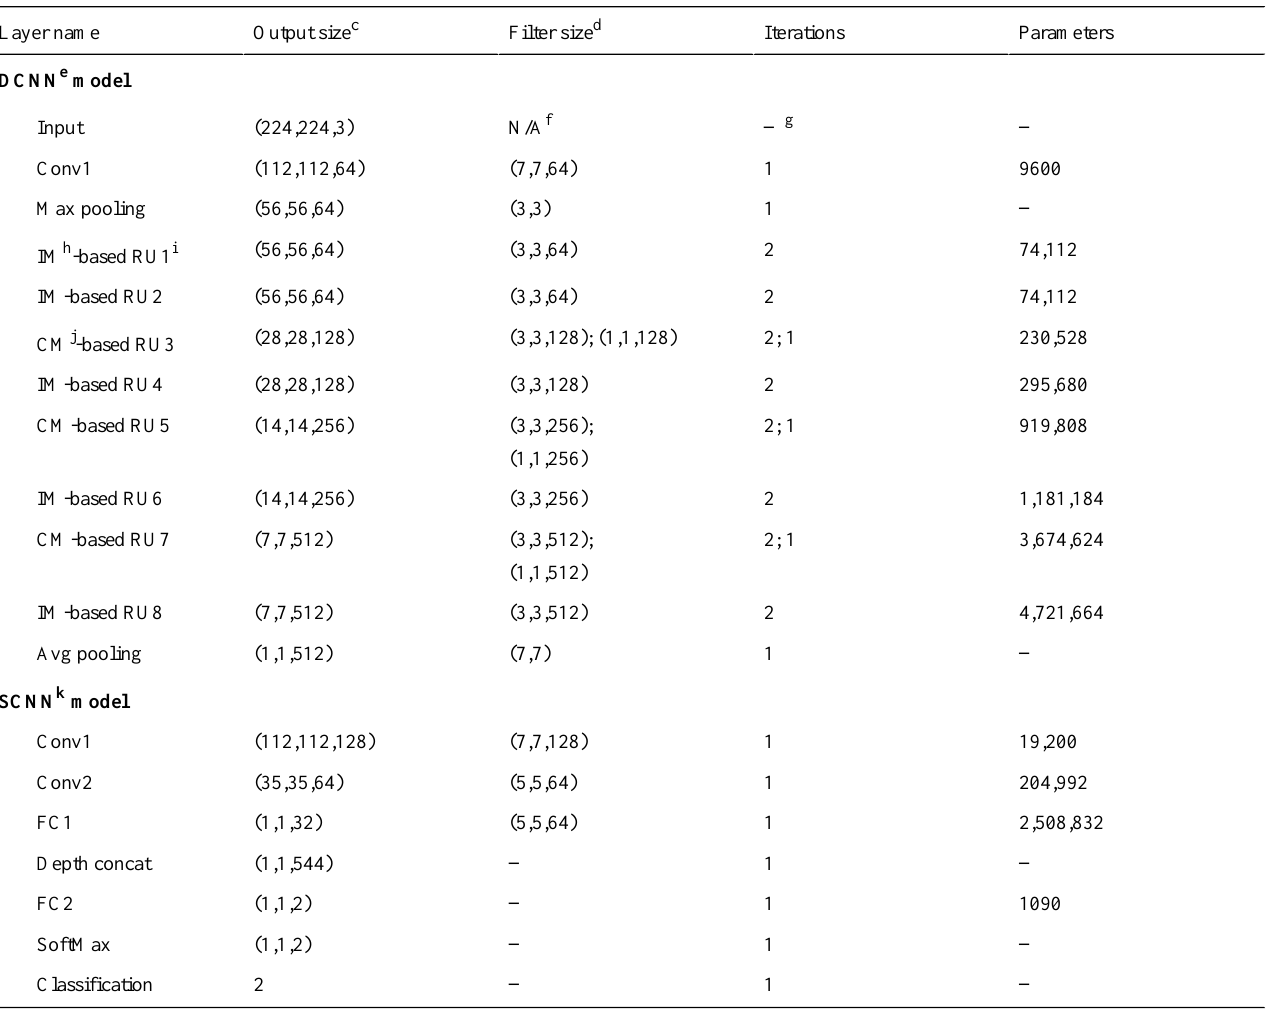
Table 1. Layer-wise configuration details of the proposed ensemble-SDCNN a model. b